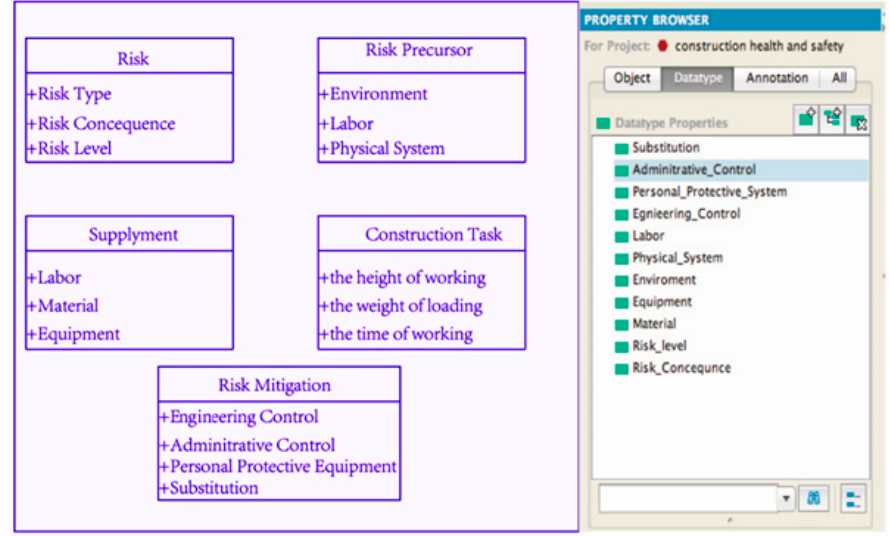
Figure 7. The conversion of UML attributes to datatype properties in HSM-Onto.